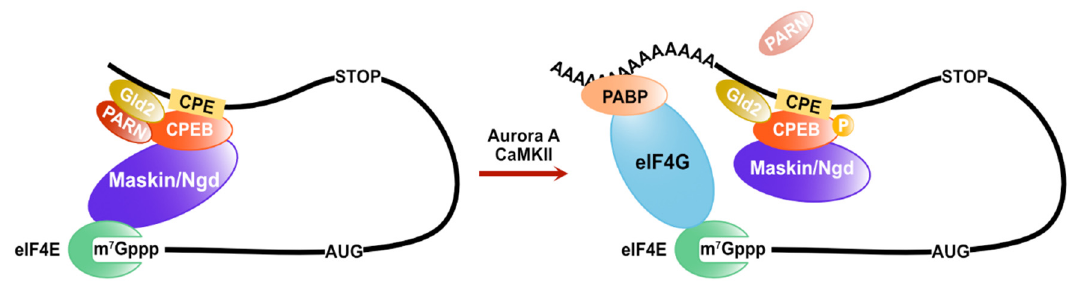
Figure 3. The regulation of the translation and the length of poly(A)-tail on CPE-containing mRNAs. CPEB proteins interact with maskin/Ngd and inhibit the assembly of eIF4F. CPEB protein is phosphorylated by Aurora A or CaMKII and induces the polyadenylation of CPE-containing mRNAs.